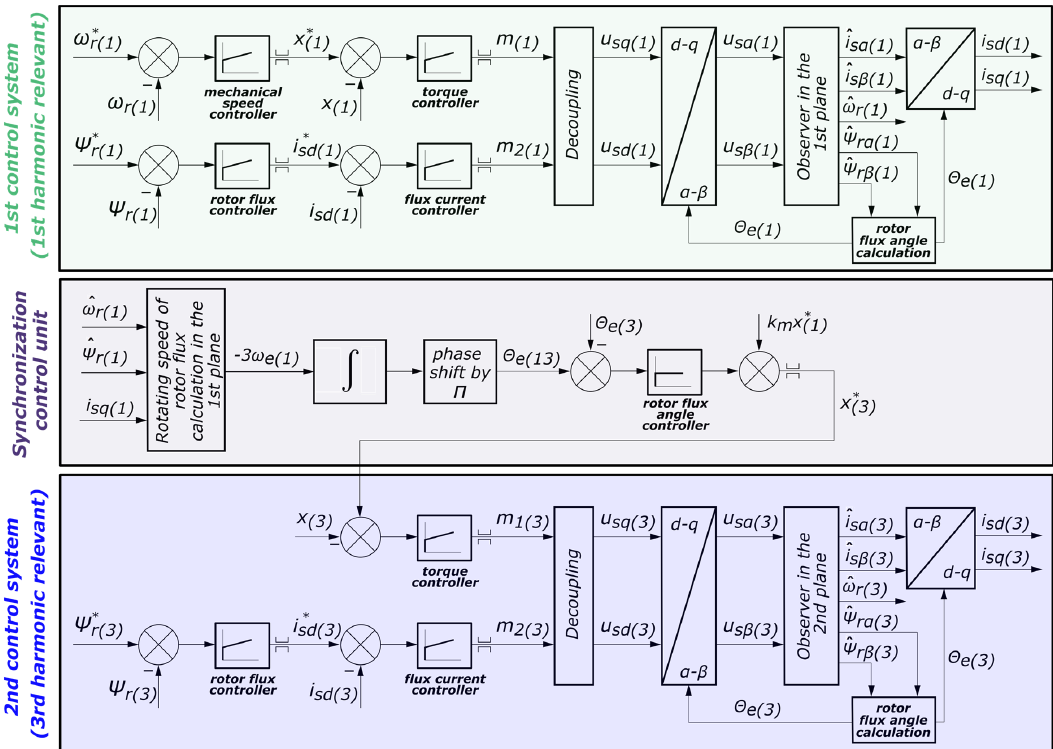
Figure 2. The control system configuration with rotor flux synchronization.